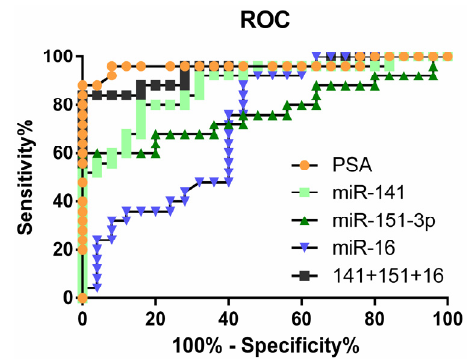
Figure 4. Receiver operating characteristic (ROC) curves to assess the utility of selected individual miRNAs compared with the combination or with PSA to differentiate localized PCa from mCRPC. ROC curves for miR-141 (light squares), miR-151-3p (triangle), miR-16 (upside-down triangle), the combination of all three miRs (dark square) and PSA (circle).